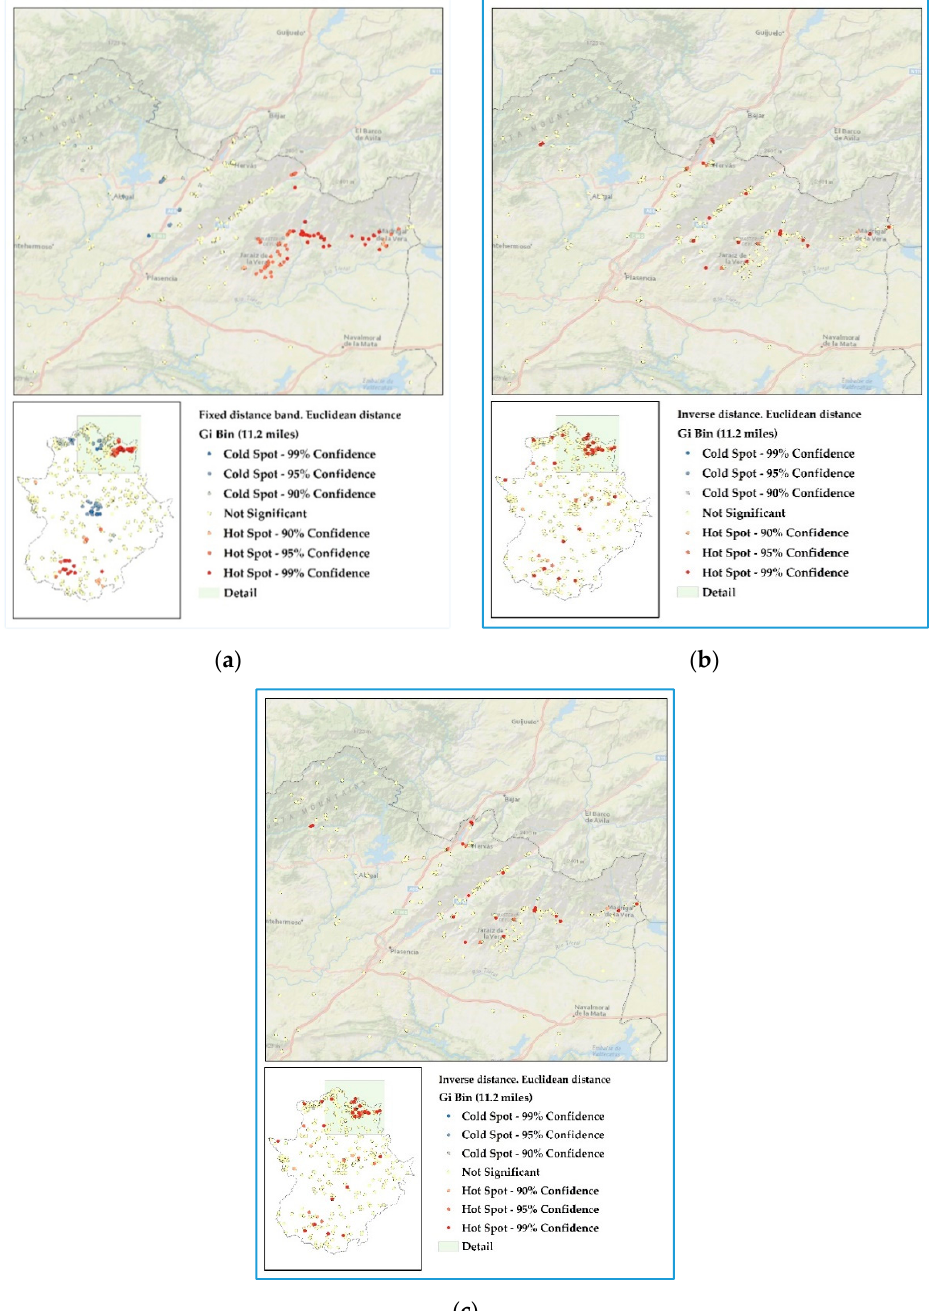
Figure 5. Hot spot analysis comparation (La Vera district details). Conceptualization of spatial relationships: fixed distance band ( a ), inverse distance ( b ) and inverse distance squared ( c ). Distance method: Euclidean distance.